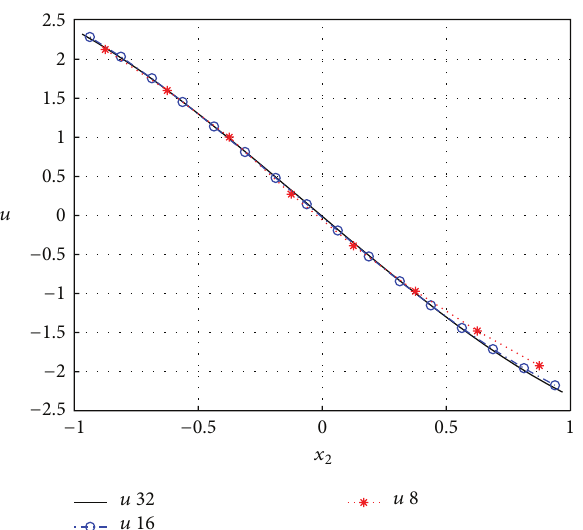
Figure 8: Some state trajectories for Example